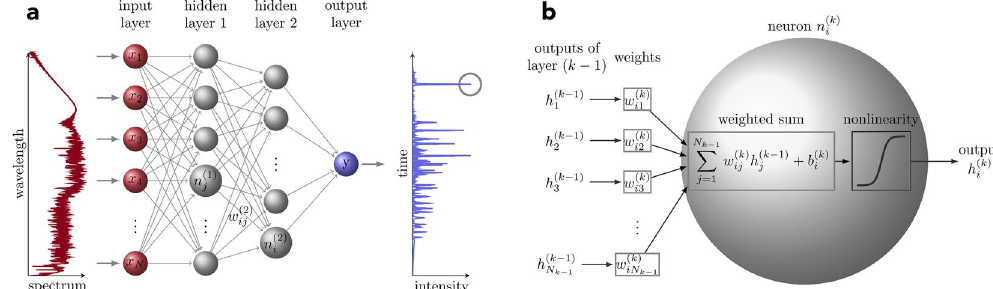
Figure 2. Schematic of the feed-forward neural network used in this work. ( a ) The input of the network is a single-shot supercontinuum spectral intensity vector =  x x x X [ , , , ] yielding the output of the network y n N 1 2 that corresponds to the peak power, duration or temporal delay of the rogue solitons. The network consists of two fully connected hidden layers and a single output neuron. ( b ) shows the operation of a single neuron. The k ( ) ( i th neuron in layer k ) is calculated as a weighted sum between the outputs from output of a generic neuron n i k ( ) and the previous layer k − 1 and the weights of each connection w ijk ( ) which is followed by adding a bias term b i nonlinearity. See Methods for more